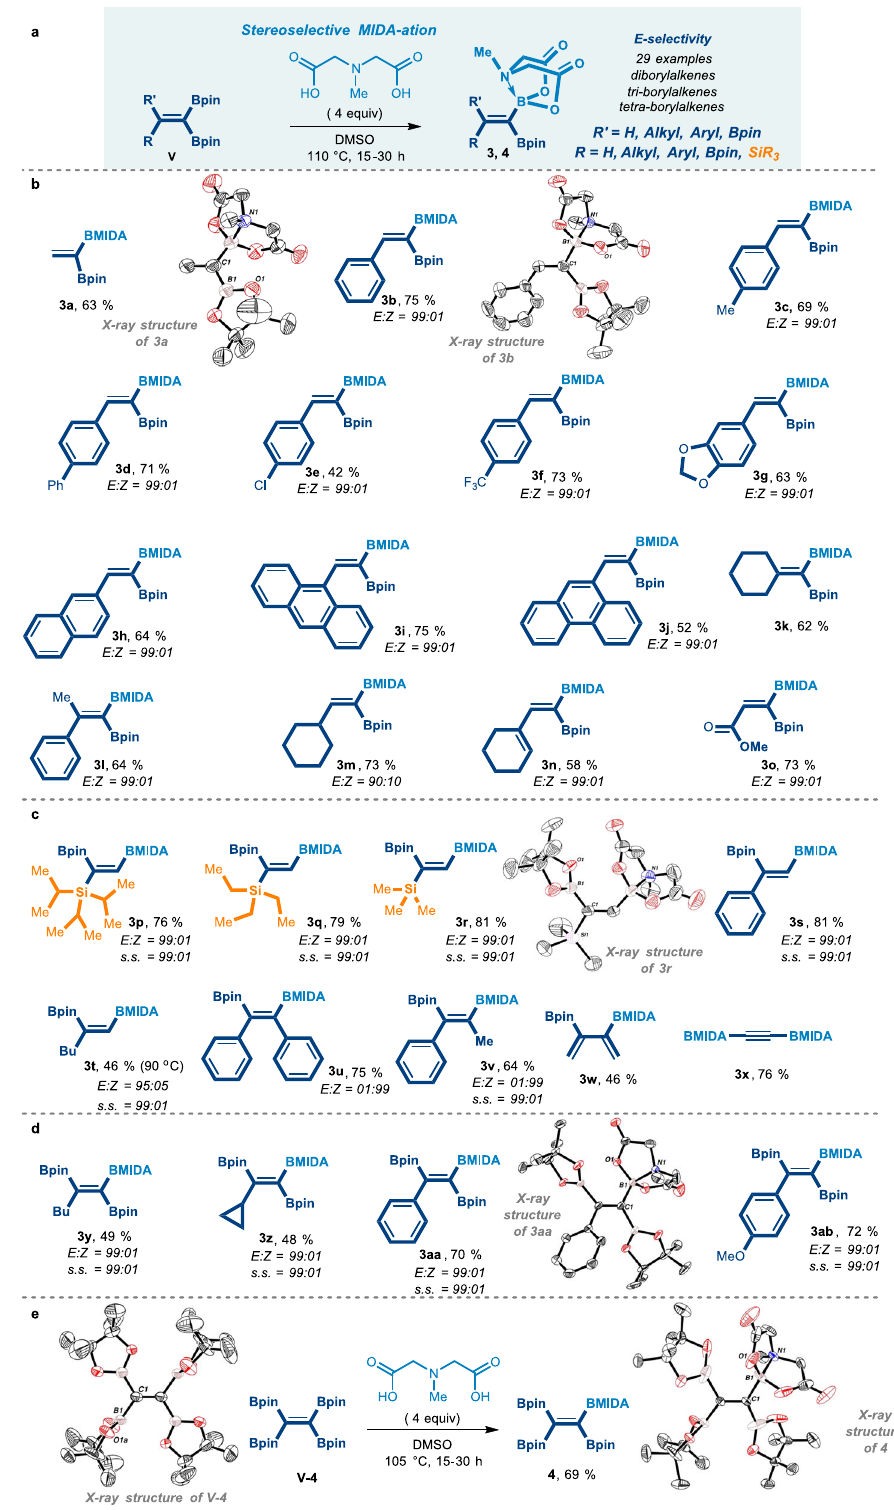
Fig. 4 | The stereoselective MIDA-ation Boron-Masking strategy. a General scheme of the presented MIDA-ation reaction. b The reaction scope of gem - diborylalkenes. c The reactionscope of1,2-diborylalkenes. d The reaction scopeof